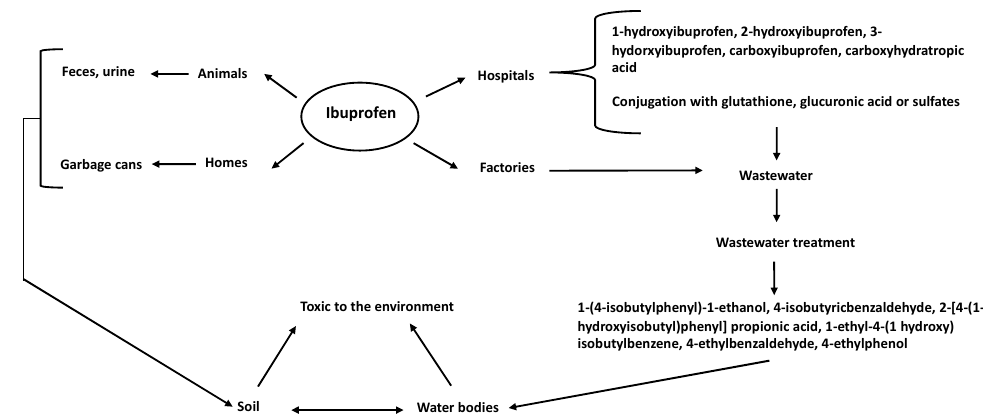
Figure 1. Routes of ibuprofen entry into the environment. Ibuprofen reaches the ground or bodies of water from different sources, such as hospitals, factories, animals and homes.